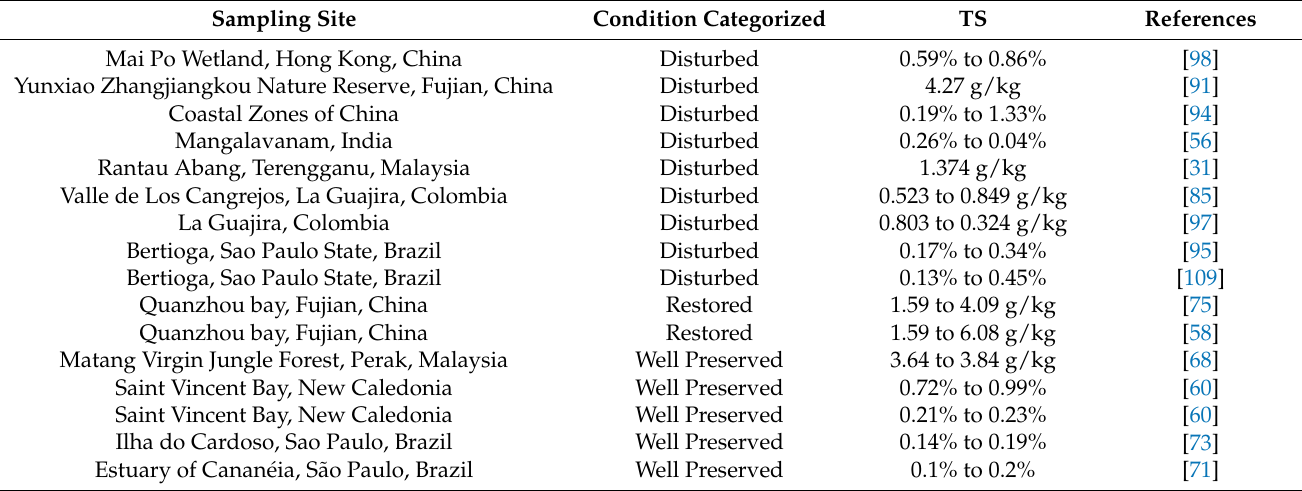
Table 4. Total sulfur content of sampled mangrove